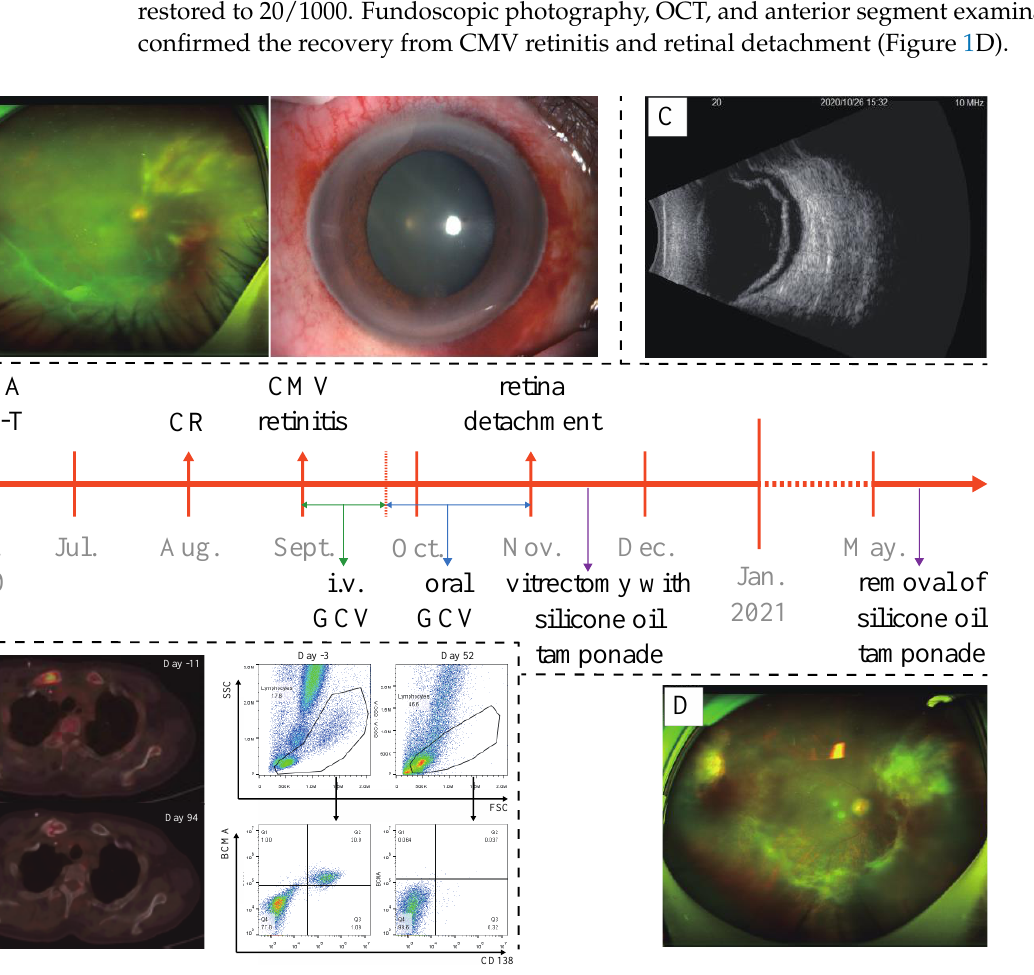
Figure 1. A timeline of the case. ( A ) Post-CAR-T flow cytometry of bone marrow sample and PET-CT confirmed the complete remission of multiple myeloma. ( B ) Anterior segment examination and fundoscopy at the diagnosis of CMV retinitis. ( C ) Ultrasonography of the right eye confirmed retinal detachment. ( D ) Fundoscopy after the removal of silicone oil tamponade, showing recovery from CMV retinitis and retinal detachment.